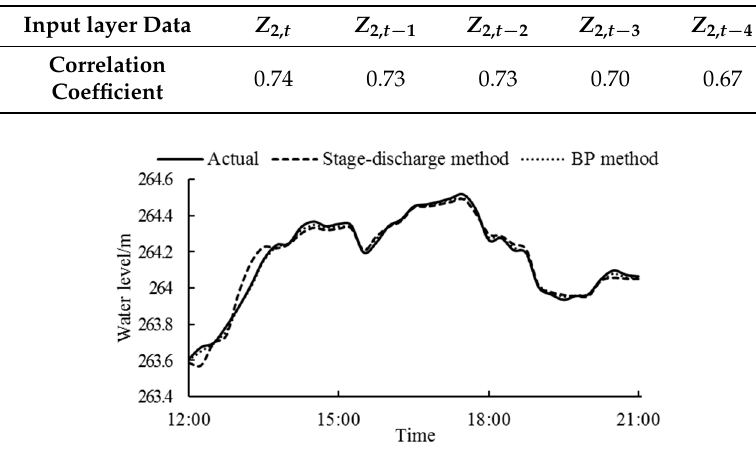
Figure 5. Calculation results of Pankou’s tail water level.